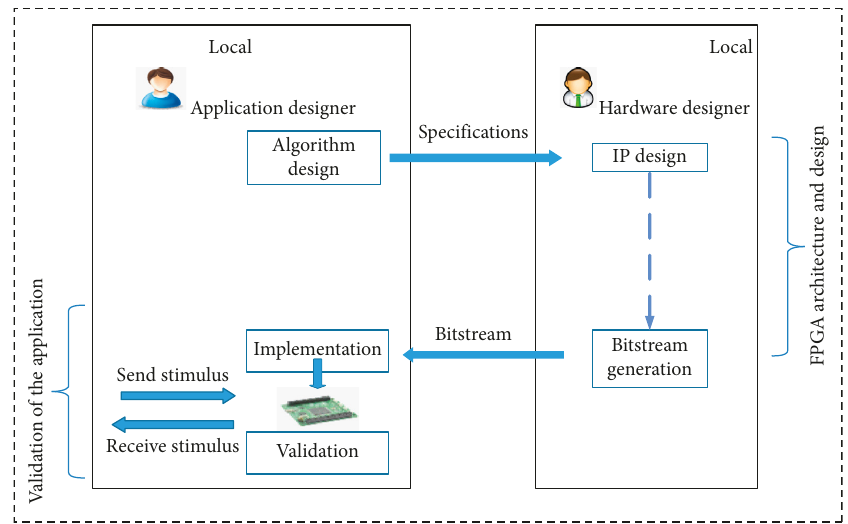
Figure 1: Interactions between application designers and hardware designers for FPGA design and implementation.